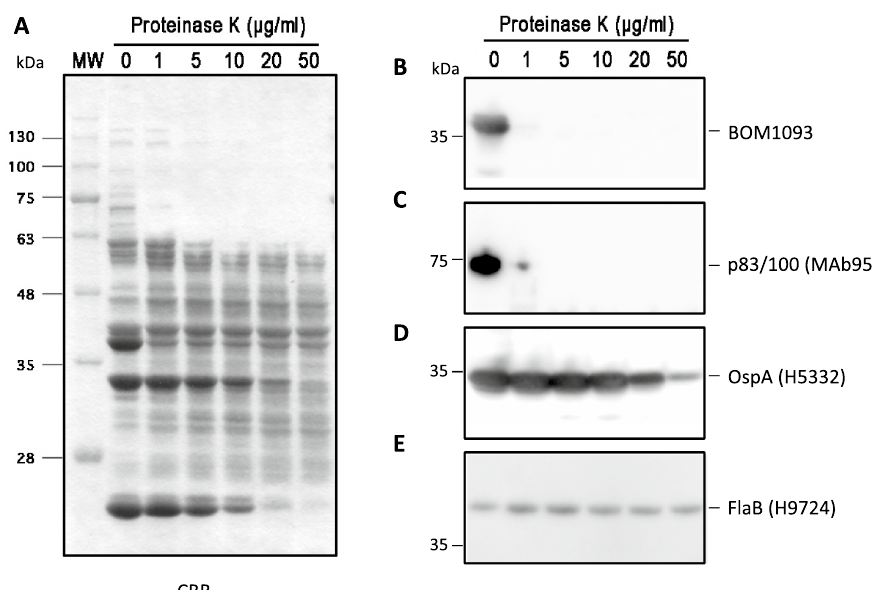
Figure 3. Protease treatment affects surface exposed protein, BOM1093. B. garinii HT59G/pBOM1093 cells were incubated with the indicated concentrations of proteinase K. After 1 h of incubation, the cells were lysed by SDS-PAGE buffer, and each protein lysate was separated by 12.5% SDS-PAGE. ( A ) Total proteins were detected by Coomassie Brilliant Blue (CBB) staining, ( B ) BOM1093 was detected with anti-BOM1093 rabbit serum (dilution 1:1000), ( C ) P83/100 was detected with MAb958 (dilution 1:1000), and ( D ) OspA was detected with MAb H5332 (dilution 1:1000). ( E ) Flagellin was detected with MAb H9724 (dilution 1:1000) by western